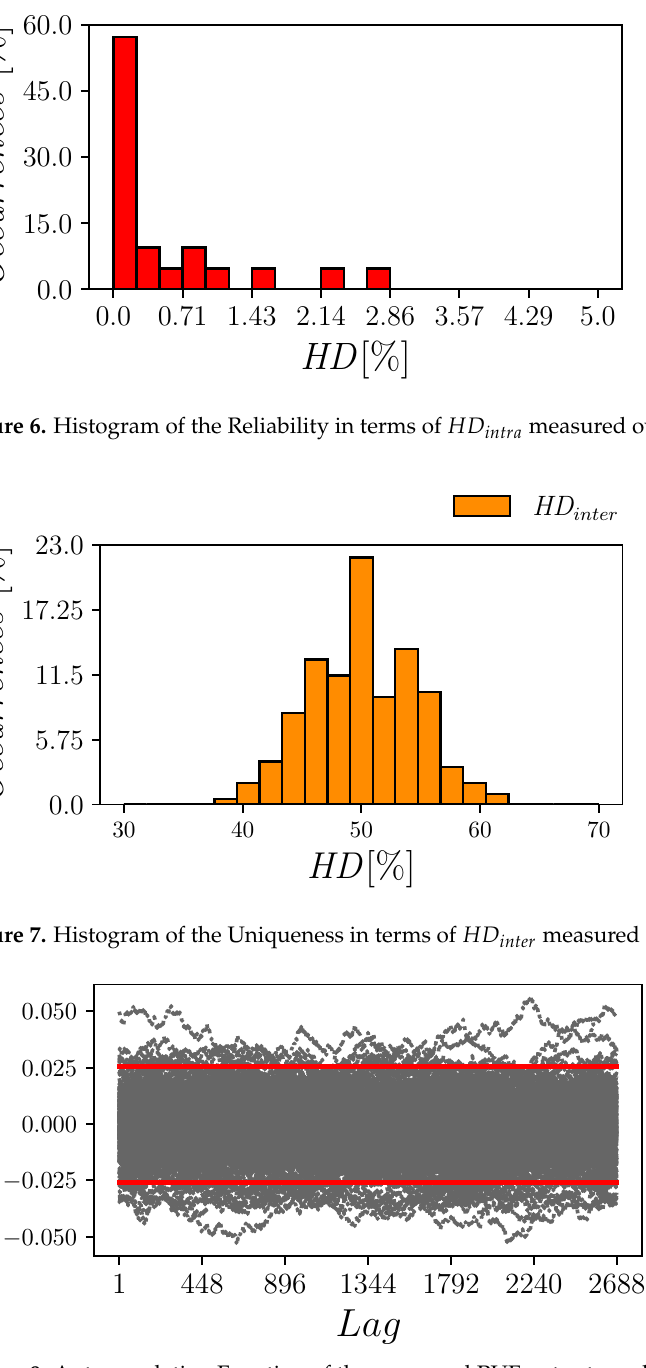
Figure 8. Autocorrelation Function of the measured PUF outputs: red lines denote the boundary of the 95% confidence